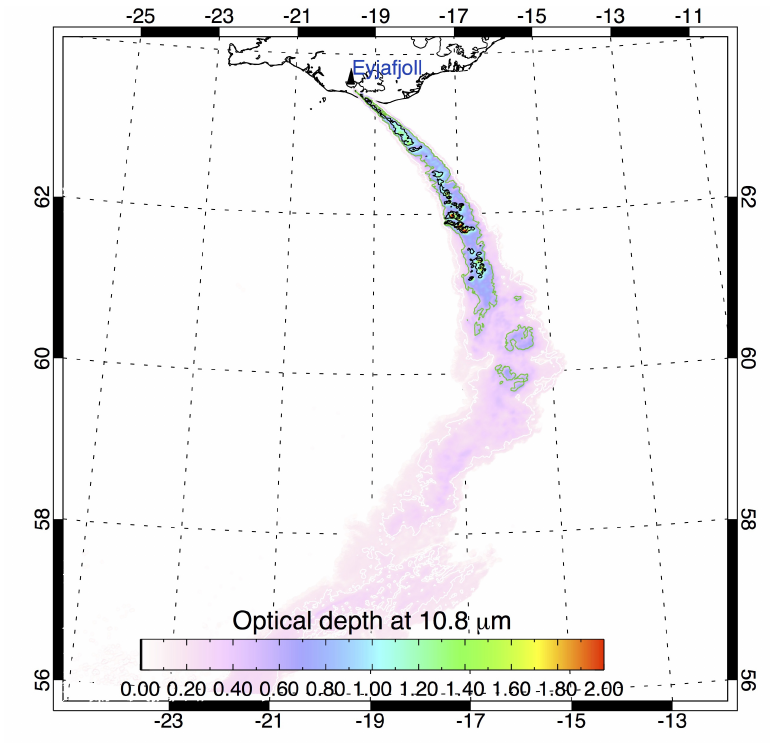
Figure 1. MODIS/Aqua optical depth retrieval for the plume from the Eyjafjallajökull volcanic eruption of 8 May, 2010 at 13:35 UTC.